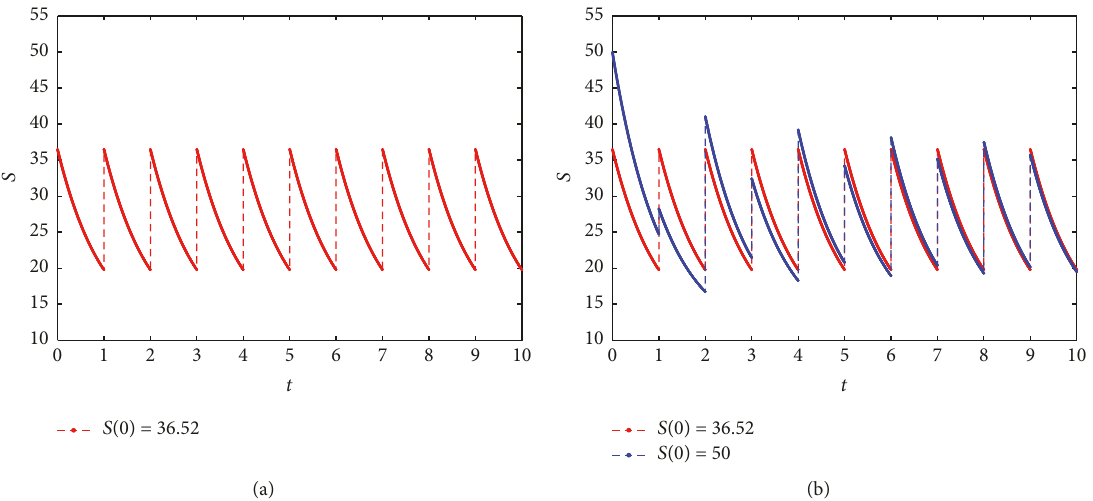
Figure 2: (a) The period- 𝑇 solution to (39) with 𝑏 = 4.8 and the initial point (0, 36.52) ; (b) two solutions to system (39) with the initial points (0,36.52) and (0,50) .